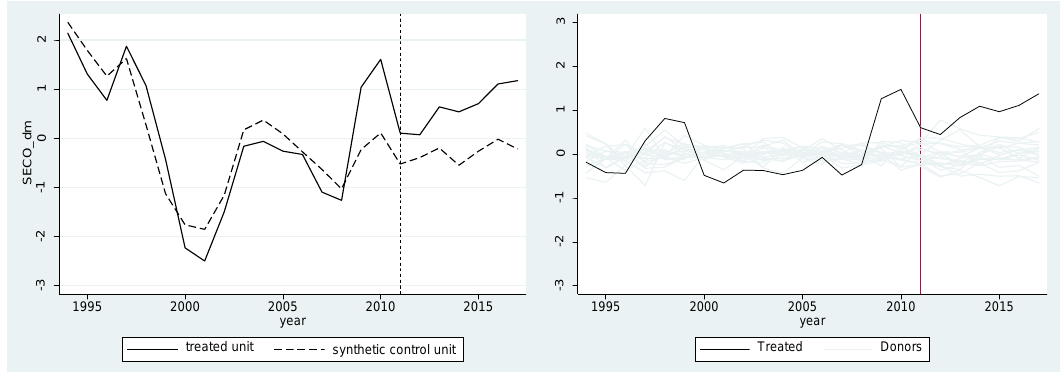
Figure 8. Outcome for Neuchâtel: Demeaned SC and unemployment rate, including all pre-treatment variables as